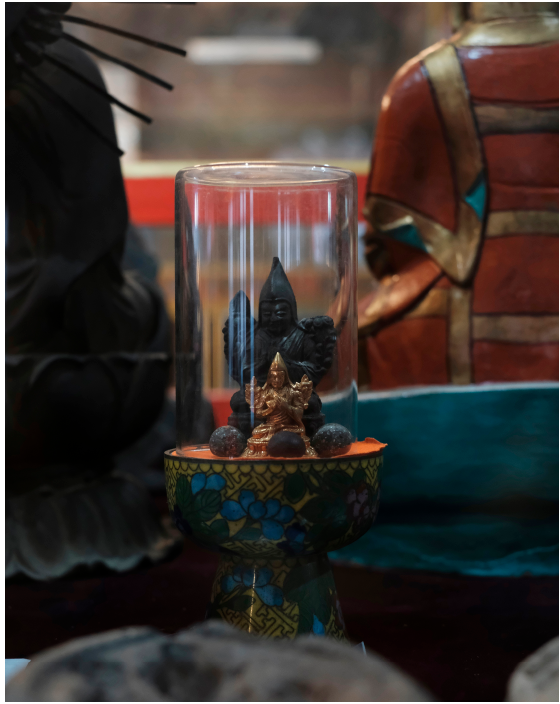
Figure 5. Close-up view of the two shiny yangdz é pills and one black jinten pill made apparently during the first Domo Geshe Rinpoche’s time. Tharpa Chöling Monastery Museum, Kalimpong, December 2018. Photo by